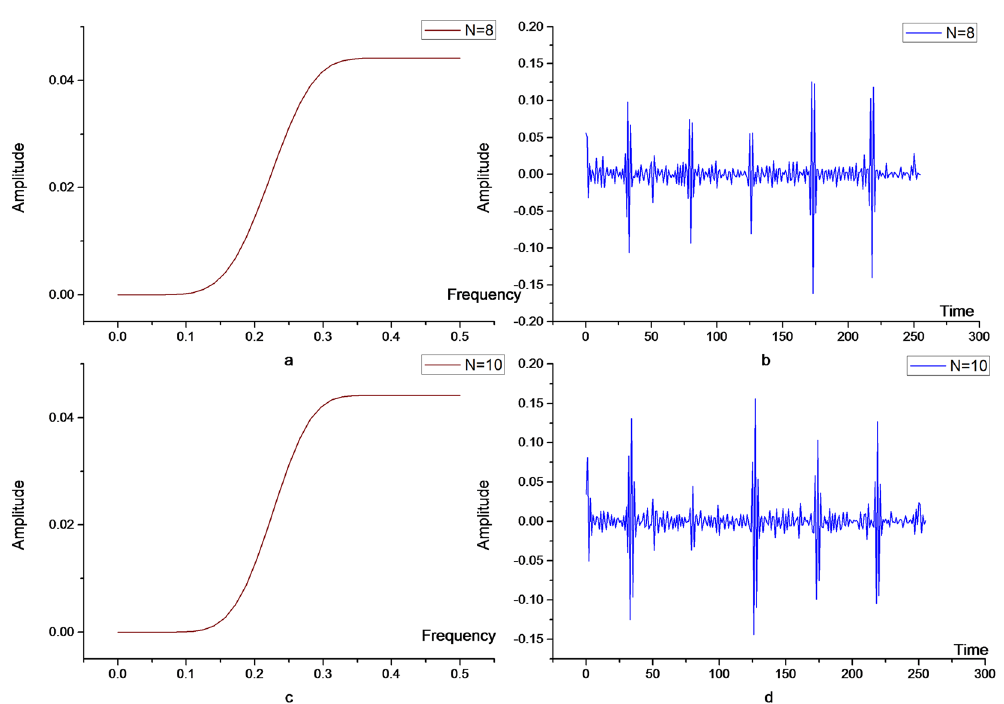
Figure 4. High frequency components of ECG signals after 8- (above) and 10-order vanishing moments